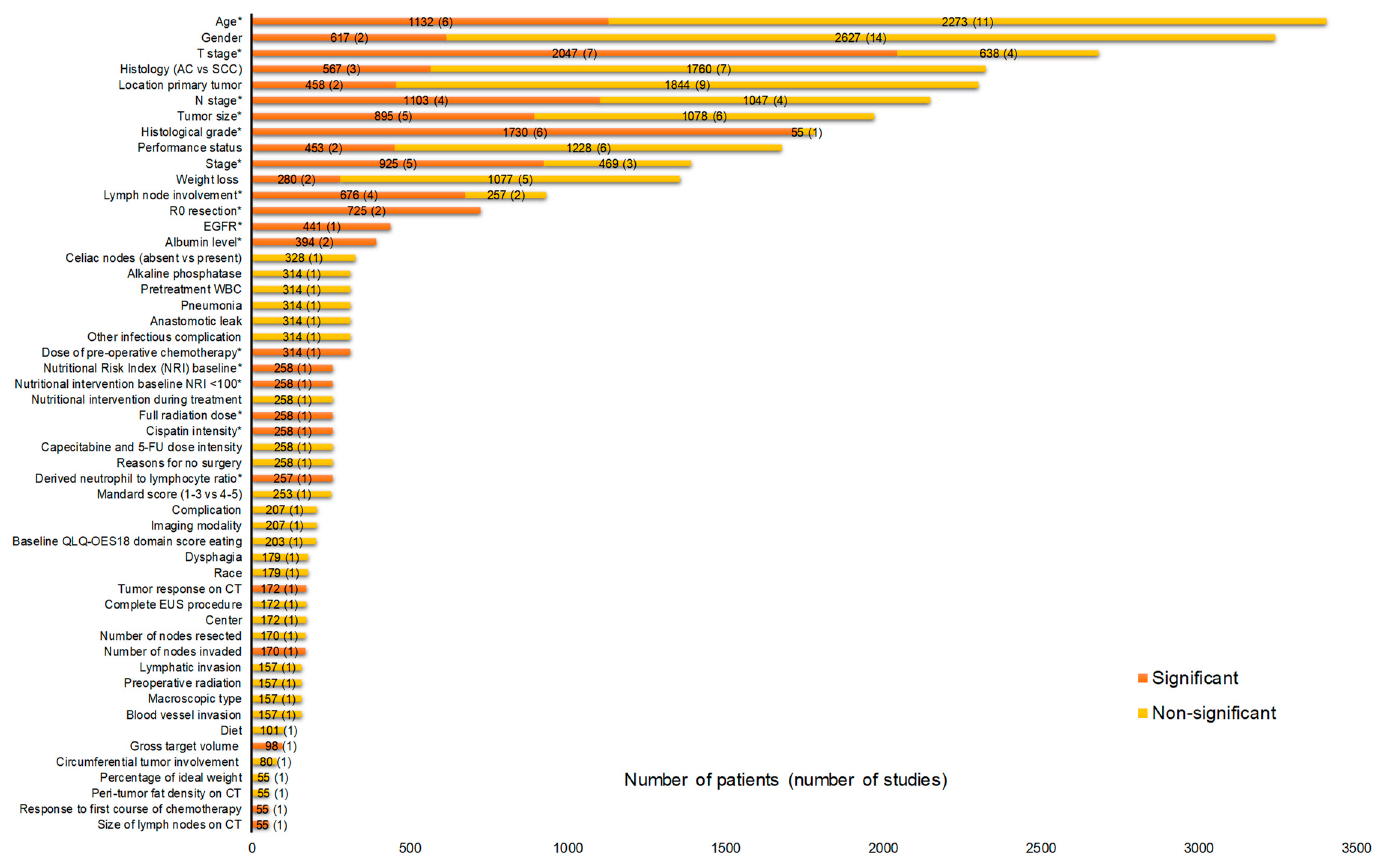
Figure 3. Prognostic factors for the curative treatment of esophageal cancer identified from OS multivariate analyses in at least one RCT. In total, there were 28 RCTs contributing to Figure 3 with 16 investigating neoadjuvant therapy [10,11,54,58,61,62,64–66,69,70,73,74,76,80,83], seven definitive chemoradiotherapy [57,60,71,72,75,82,98], three adjuvant therapy [67,77,79], and two radiotherapy alone [63,68]. * Potentially clinically relevant factors according to the criteria described in the method section. AC = Adenocarcinoma; CT = Computed tomography; EGFR = Epidermal growth factor receptor; EUS = Endoscopic ultrasound; NRI = Nutritional risk index; QLQ = Quality of life questionnaire; SCC = squamous cell carcinoma; WBC = White blood cell count.